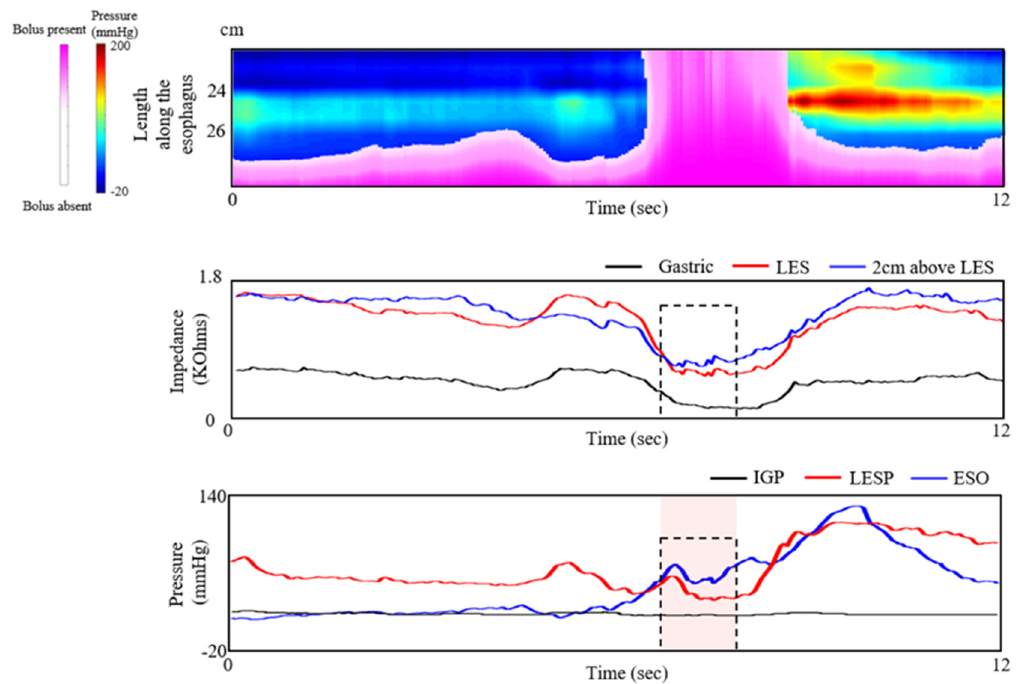
Figure 3. Successful esophageal emptying indicated by successful bolus transmission (BT) through the lower esophageal sphincter (LES). Upper panel: The esophageal pressure topography of the distal esophagus and LES. Middle panel: Impedance signals used to determine the bolus presence. Lower panel: Pressure signals used to identify the periods during which a flow-permissive gradient existed, when esophageal pressure (blue line) exceeded both LES and intragastric pressures. BT occurred when both criteria (bolus presence and trans-LES flow permissive pressure gradient) were met.